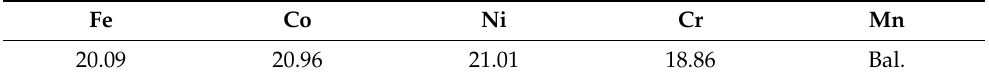
Table 1. Specific nominal composition of CoCrFeNiMn high-entropy alloy powders (wt. %). Fe Co Ni Cr Mn 20.09 20.96 21.01